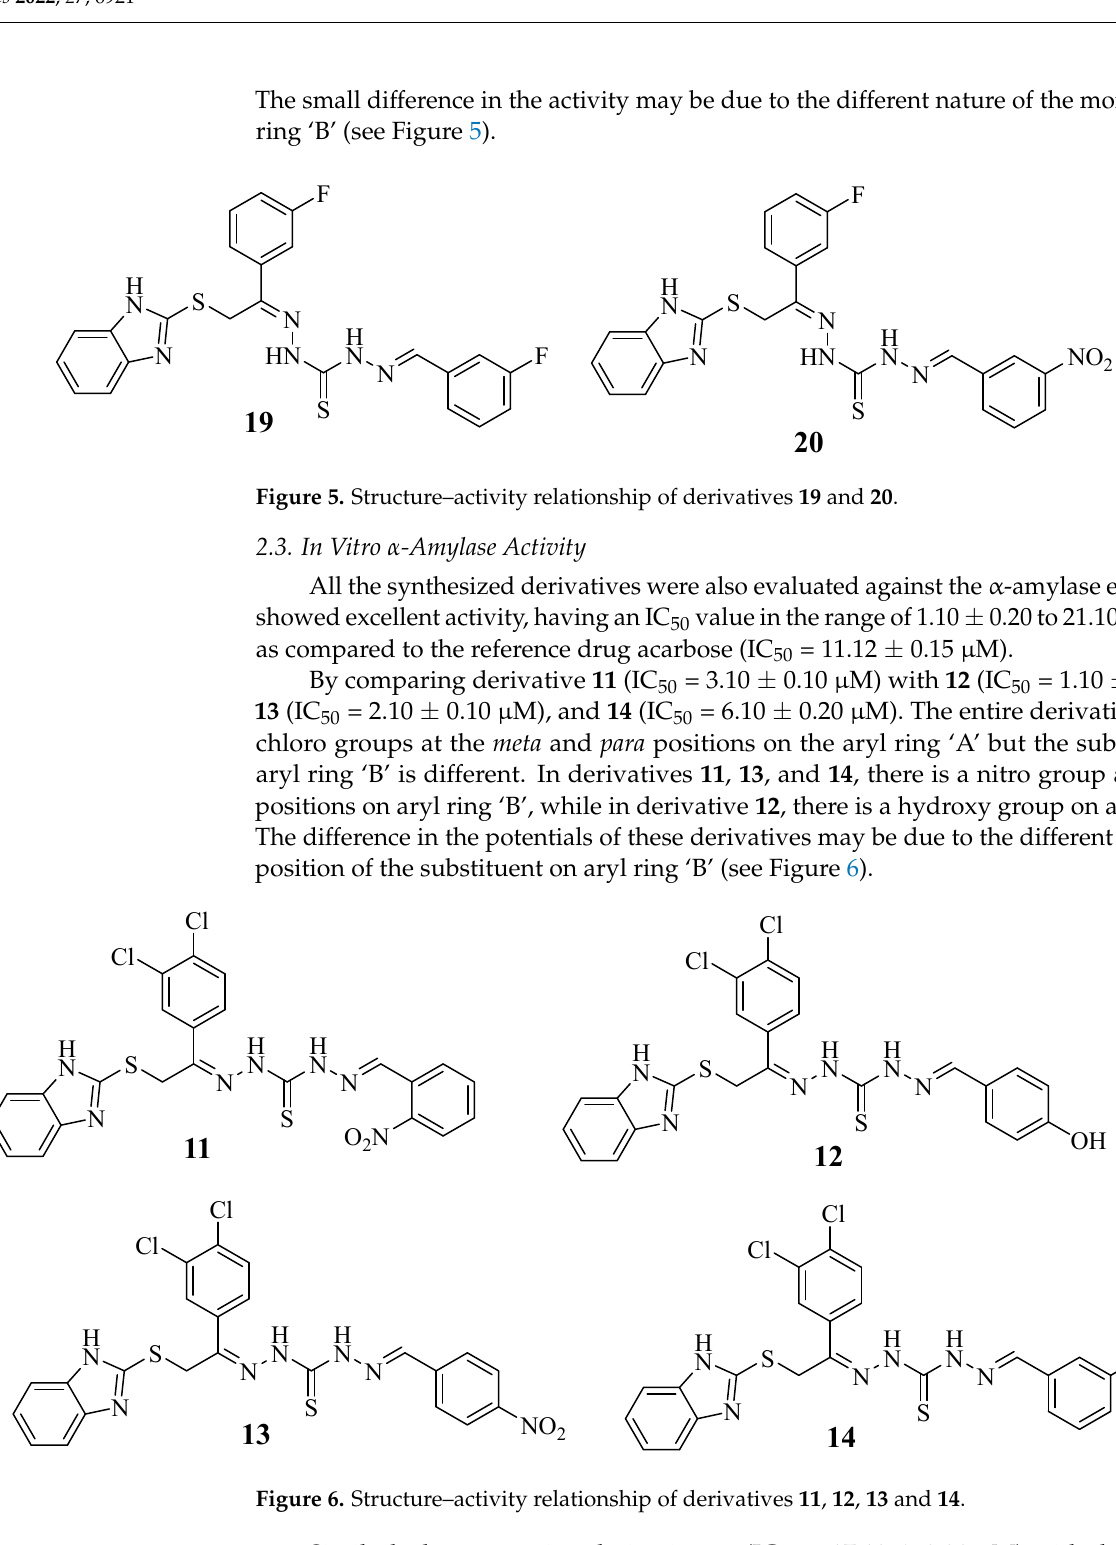
Figure 4. Structure-activity relationship of derivatives 10 , 12 and 16 .